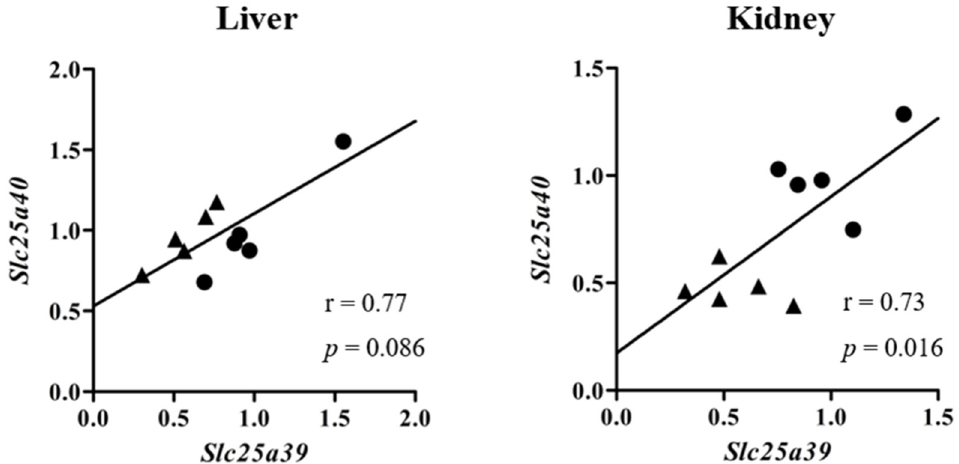
Figure 2. Correlation between relative mRNA levels of Slc25a39 and Slc25a40 in the liver and kidneys of sham and bile duct ligation (BDL) mice. Closed circles and triangles represent sham and BDL mice, respectively.